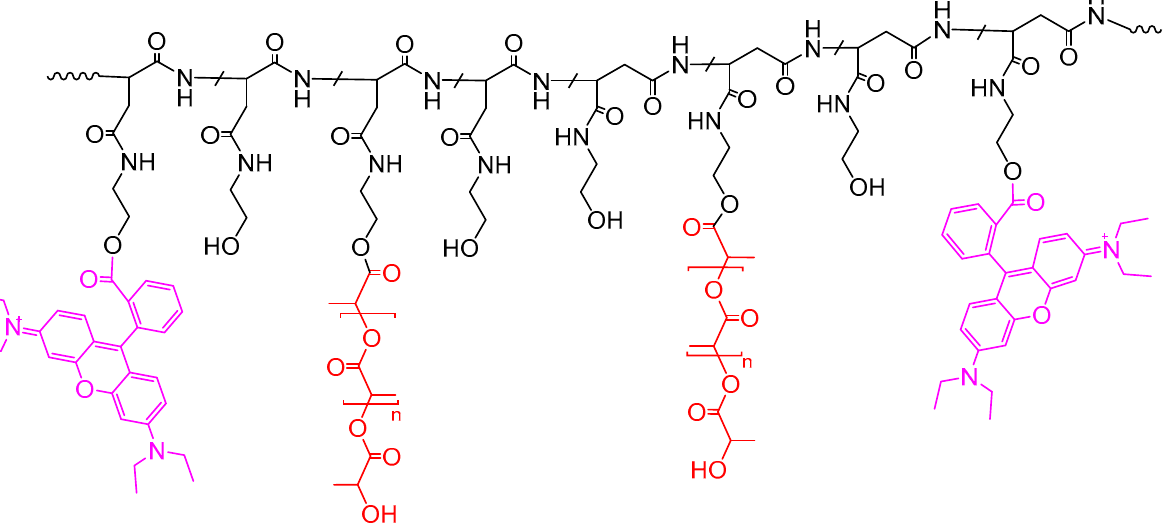
Figure 3. The chemical structure of PHEA–g–RhB–g–PLA graft copolymer (Fluo-P) ( n =